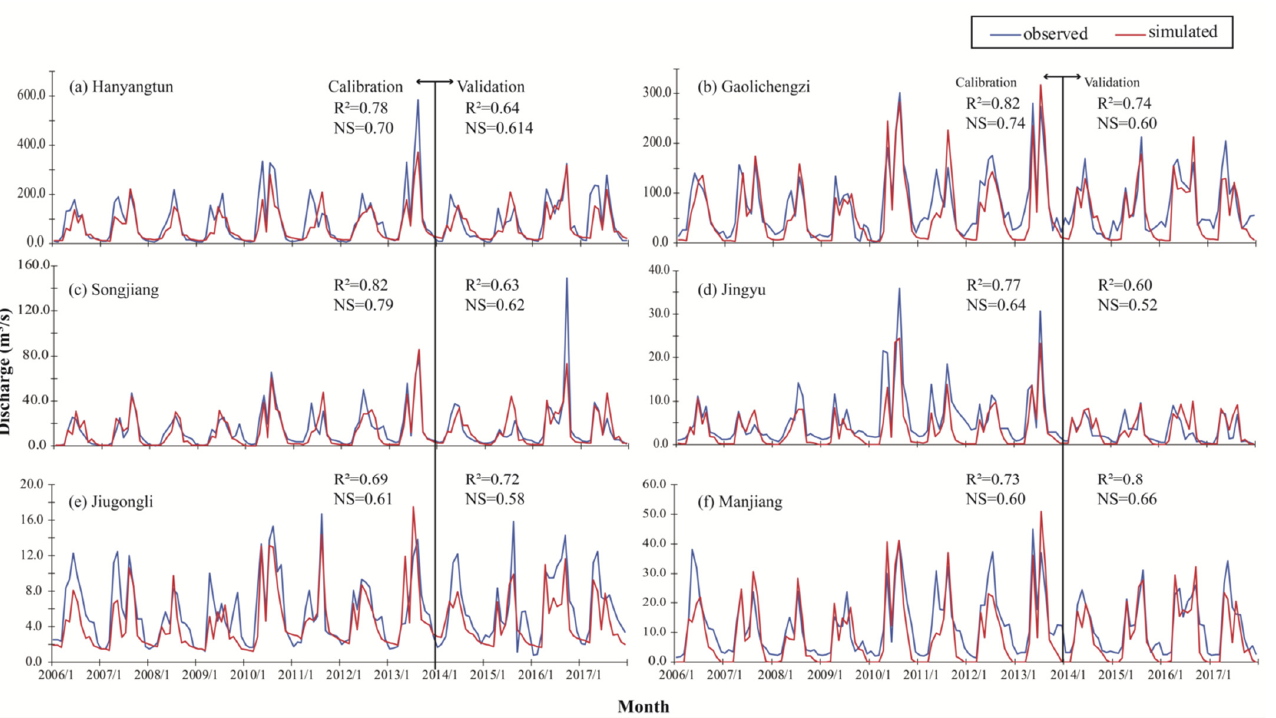
Figure 3. Observed and simulated discharge for six monitoring points and NS and R 2 values in calibration and validation periods.